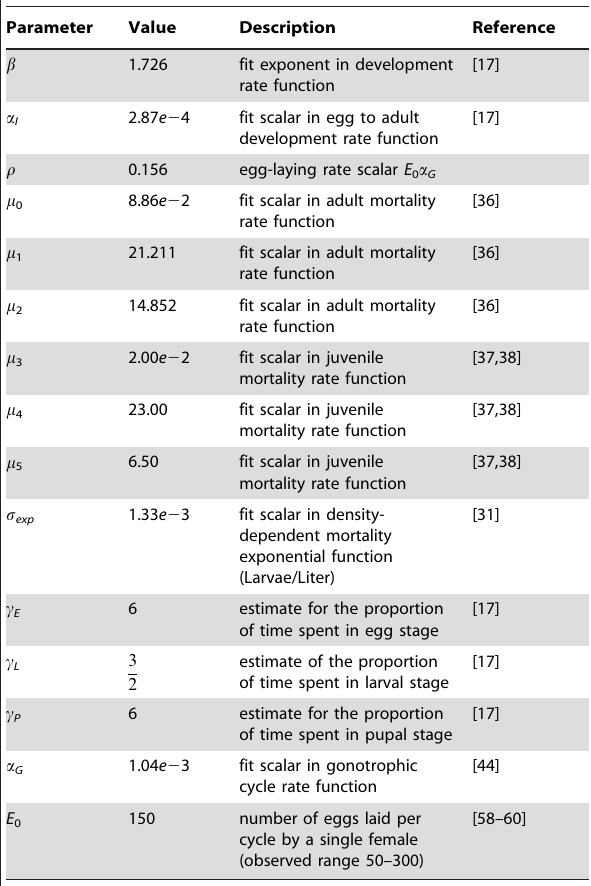
Table 1. Parameter